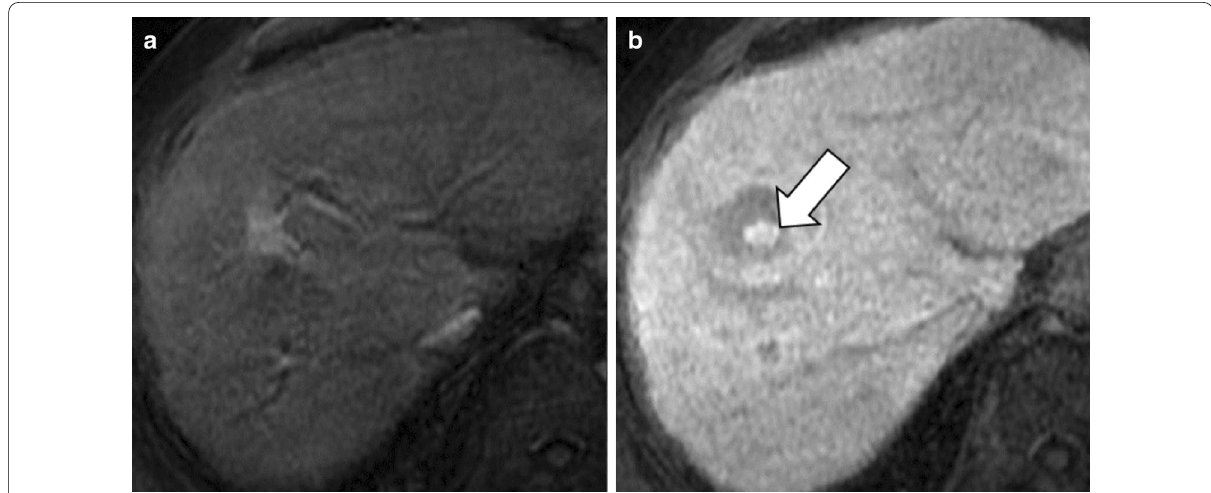
Fig. 13 A 72‑year‑old man with HCV‑related cirrhosis. Gadoxetate disodium‑enhanced MRI shows a lesion with ( a ) arterial phase hyperenhancement and ( b ) nodule‑in‑nodule architecture with a smaller inner hyperintense nodule (arrow) within a larger outer hypointense nodule in hepatobiliary phase